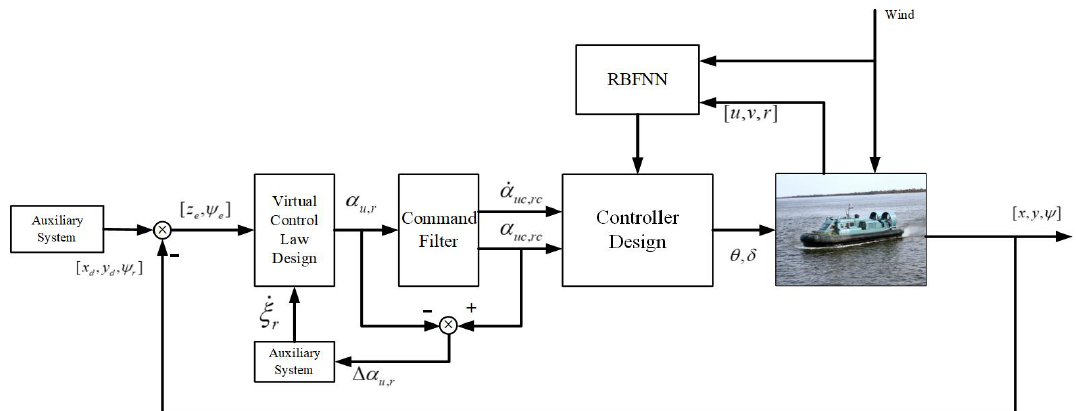
Figure 2. Scheme diagram of the trajectory tracking system of